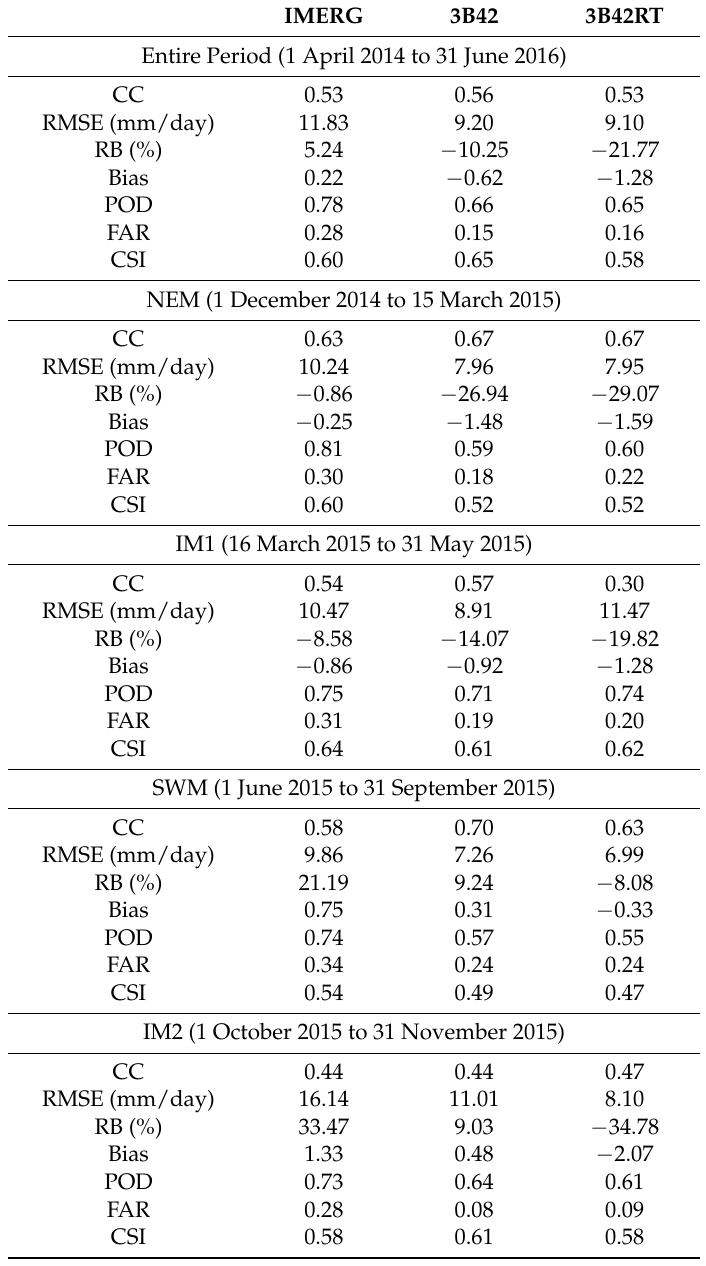
Table 2. Statistical metrics of daily precipitation measures by IMERG, 3B42 and 3B42RT in different time periods. Probability of Detection (POD); False Alarm Ratio (FAR); Critical Success Index (CSI); Correlation Coefficient (CC); northeast monsoon (NEM); southwest monsoon